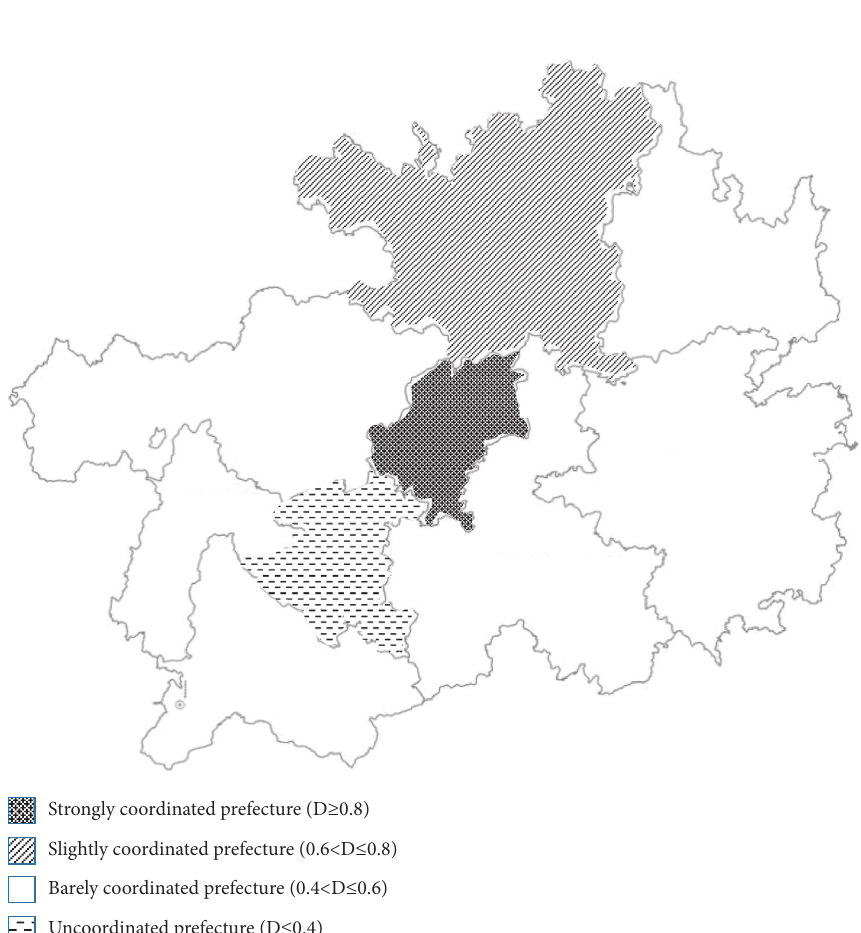
Figure 4: Coordination relationships between urbanization and ecological environment in each prefecture in 2013 and